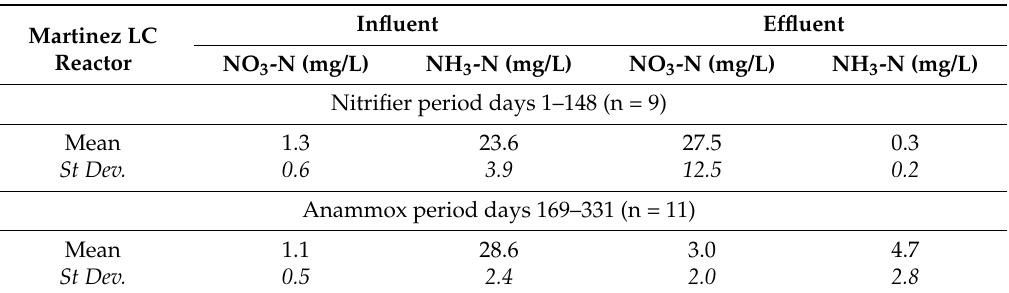
Table 4. Mean influent and effluent nitrogen concentrations for the Martinez linear-channel (LC) reactor during nitrifier and anammox dominant periods as shown in Figure 3.